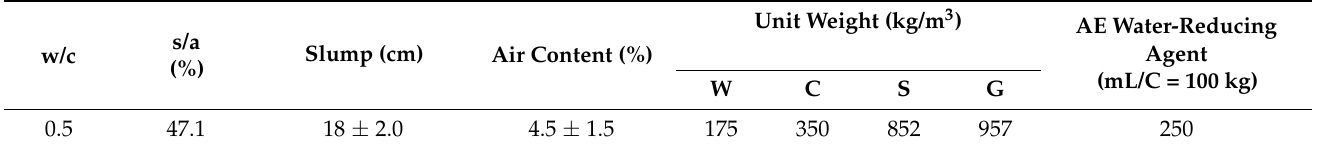
Table 2. Concrete mix proportions.